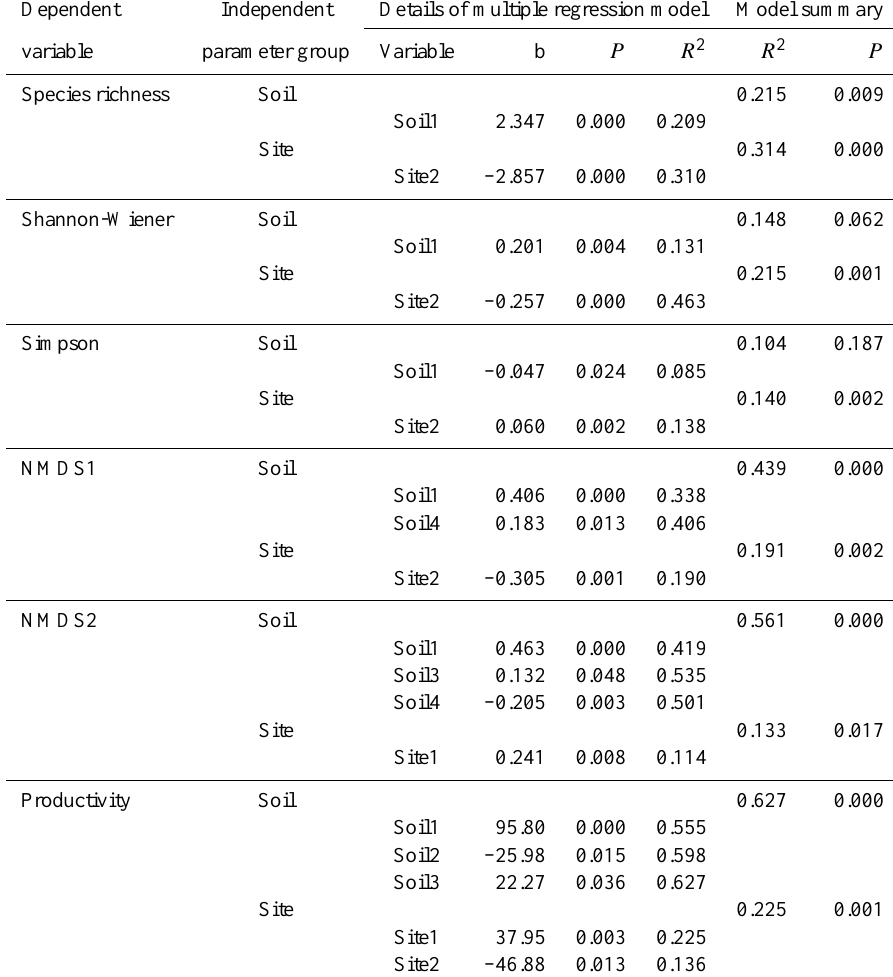
Table 2. Multiple stepwise regression models for species richness, NMDS1, NMDS2 and productivity. Separate regressions were calculated for the parameter groups of soil and site